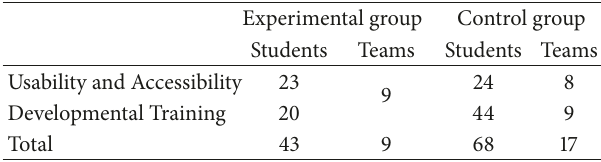
Table 2: Student distribution in groups and